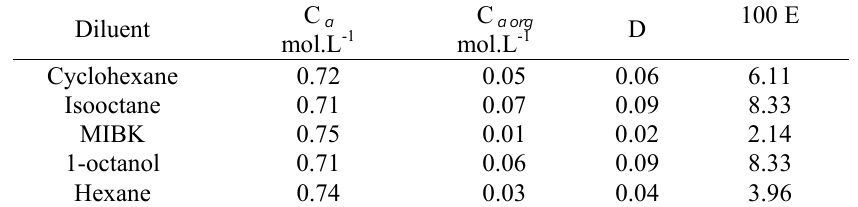
Table 2. Distribution of L(+) tartaric acid between solvents and water.